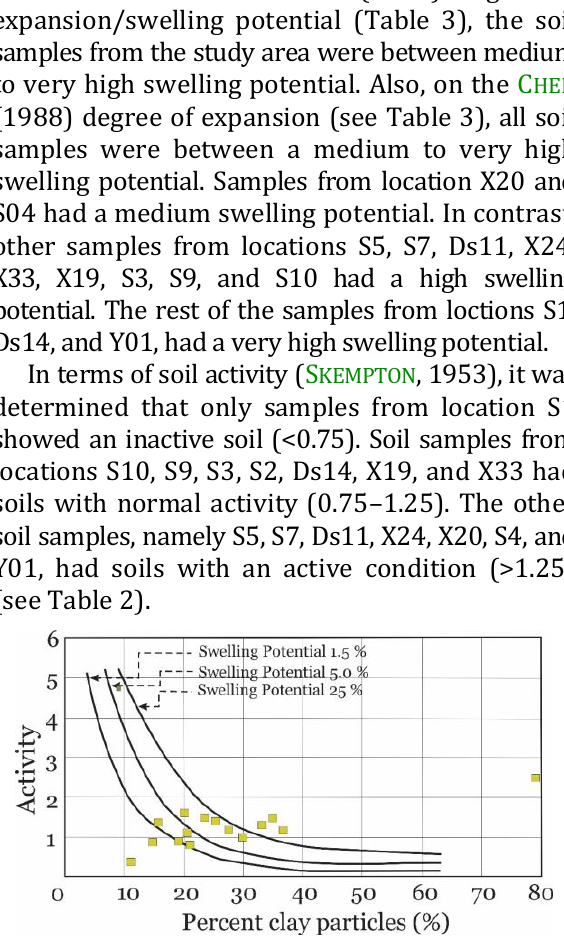
Fig. 5. Soil swelling potential on [39]